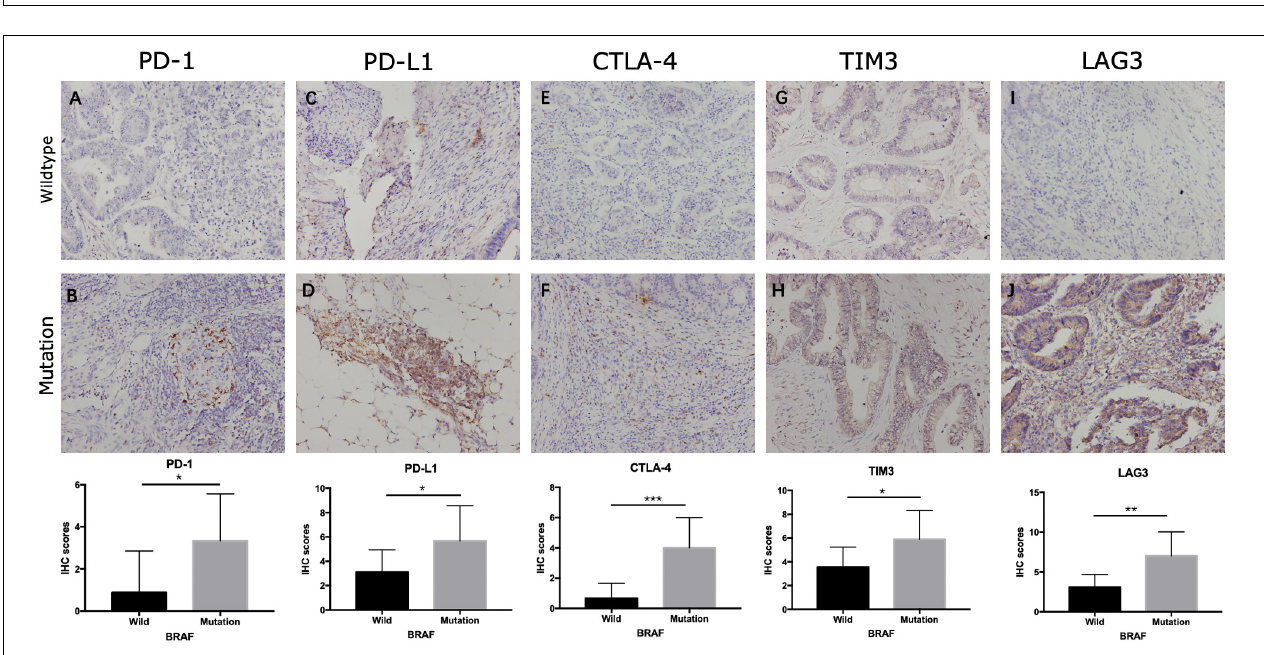
FIGURE 7 | BRAF mutation was correlated with the expression levels of PD-1 (A) , PD-L1 (B) , CTLA-4 (C) , LAG-3 (D) , and TIM-3 (E) in the TCGA cohort and the expression levels of PD-1 (F) , CTLA-4 (G) , and LAG-3 (H) in the GEO cohort. Student’s t -tests were used for all analyses.